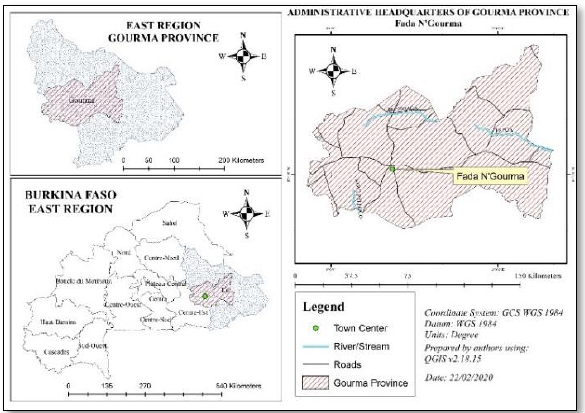
Figure 1: Administrative map of Gourma Province (SOURCE: Prepared by authors in QGIS v